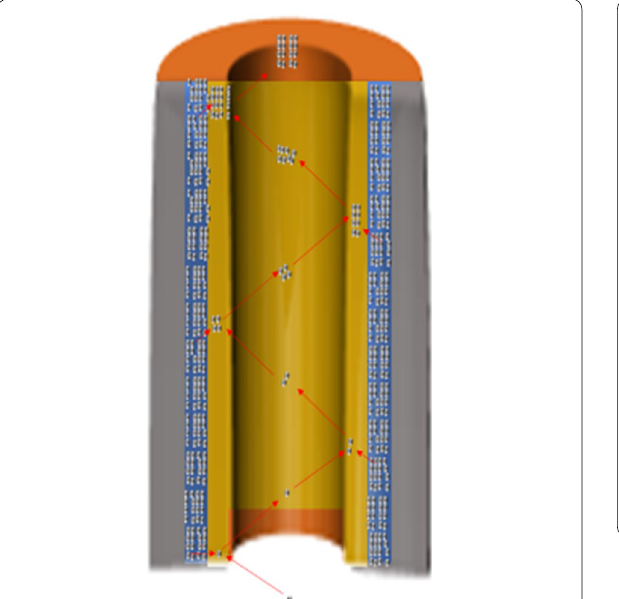
Fig. 1 MCP working state diagram